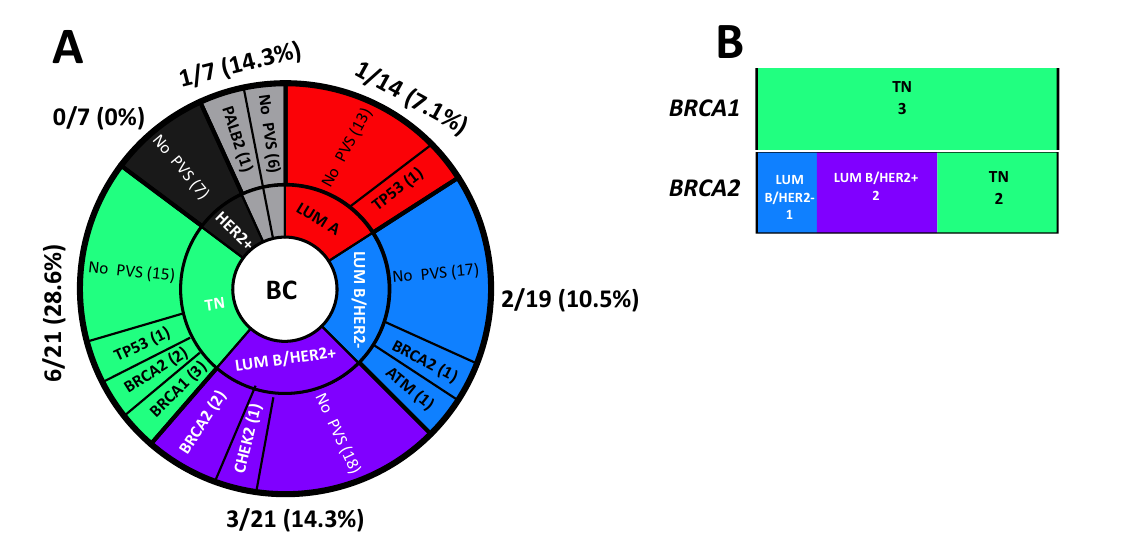
Figure 6. ( A ) Distribution of molecular subtypes in the study cohort. ( B ) Prevalence of molecular subtypes in positive BRCA1 - and BRCA2 - breast cancer patients. Table 1. Pathogenic variants identified in this